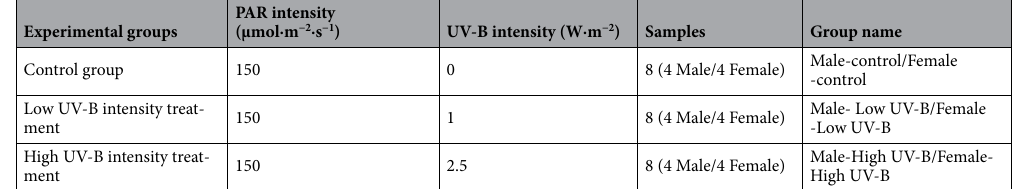
Table 1. Experimental groups of the effects of increased UV-B radiation on epiphytic bacteria of male and female S. thunbergii. Only 22 samples were actually analyzed, because DNA was unable to be extracted from 2 samples from S. thunbergii (1 female and 1 male) in the control